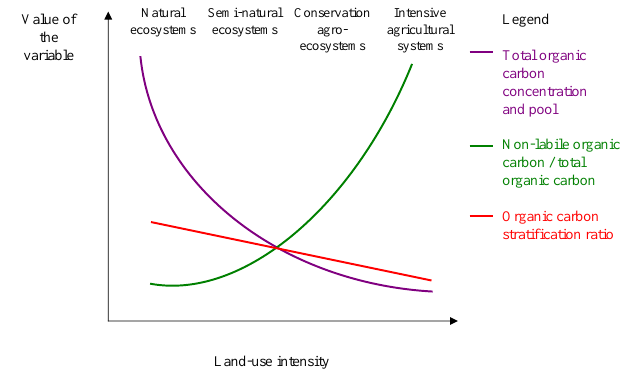
Figure 5. Land-use intensity effects on soil organic carbon dynam- ics. The y axis is indicative of the increase in the values of the con- sidered